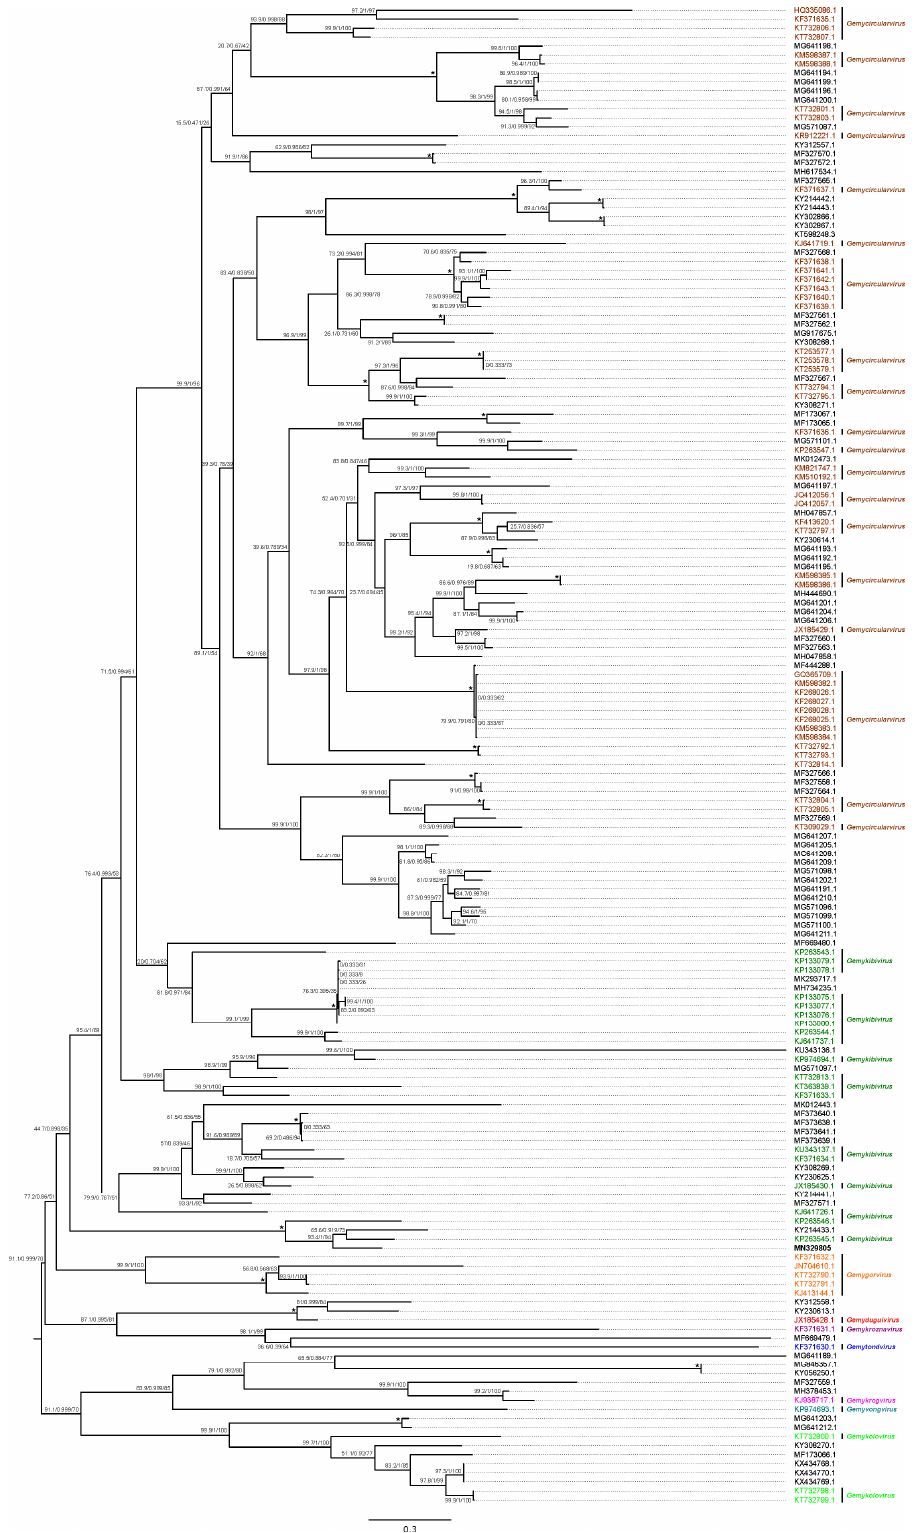
Figure 6. Phylogenetic tree of the Genomovirus Rep amino acid sequence. The tree was constructed using the LG + I + G4 substitution model, and branches are annotated with Sh-aLRT (1000 replicates), aBayes, and UF bootstrap support (1000 replicates) values, respectively. Maximum support values are shown with asterisks (*). Novel TbGkyV1 is depicted in bold. Genomoviridae genera were classified according to Varsani and Krupovic (2017). Unclassified sequences were not